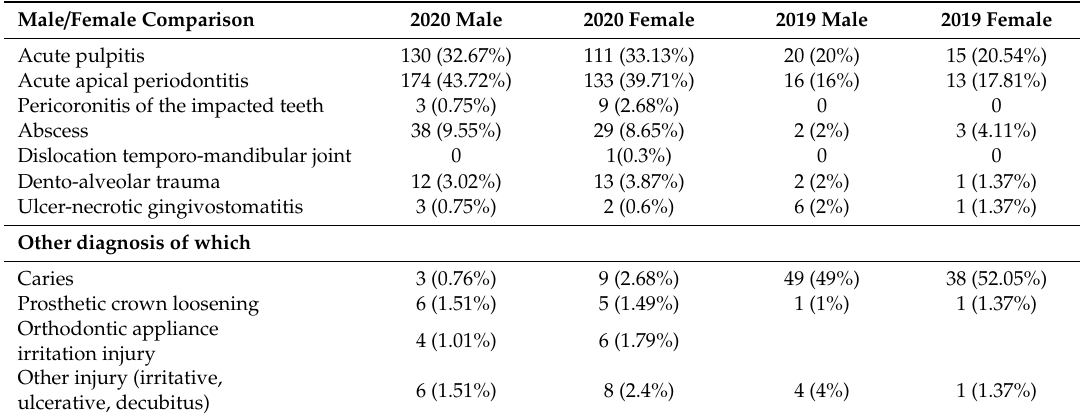
Table 3. Dental pathology distribution according to gender for April 2020 / 2019.